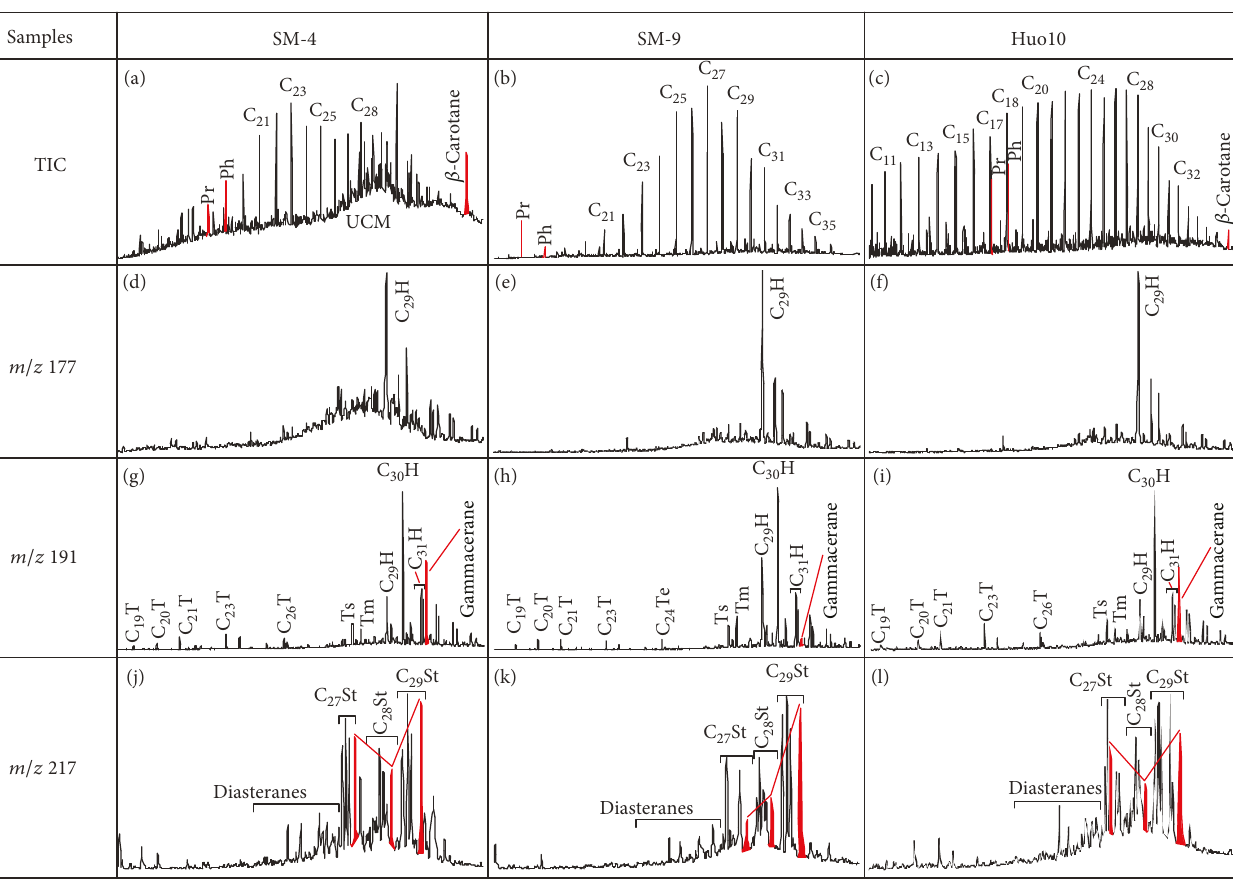
Figure 8: Selected molecular geochemical chromatograms of oil-seep and crude-oil samples from the middle segment of the southern Junggar Basin. See Figure 4 for the